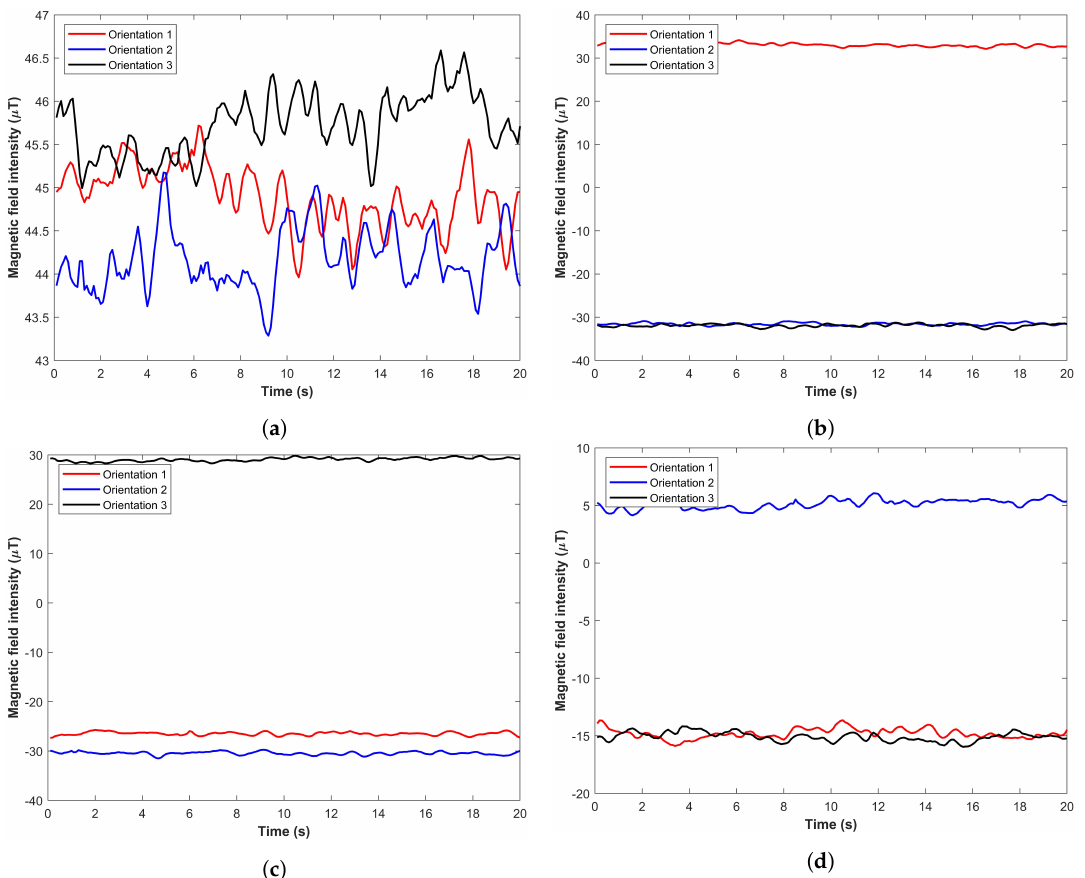
Figure 9. The magnetic field data for three orientations as described, ( a ) Magnetic F , ( b ) Magnetic x , ( c ) Magnetic y , and ( d ) Magnetic z